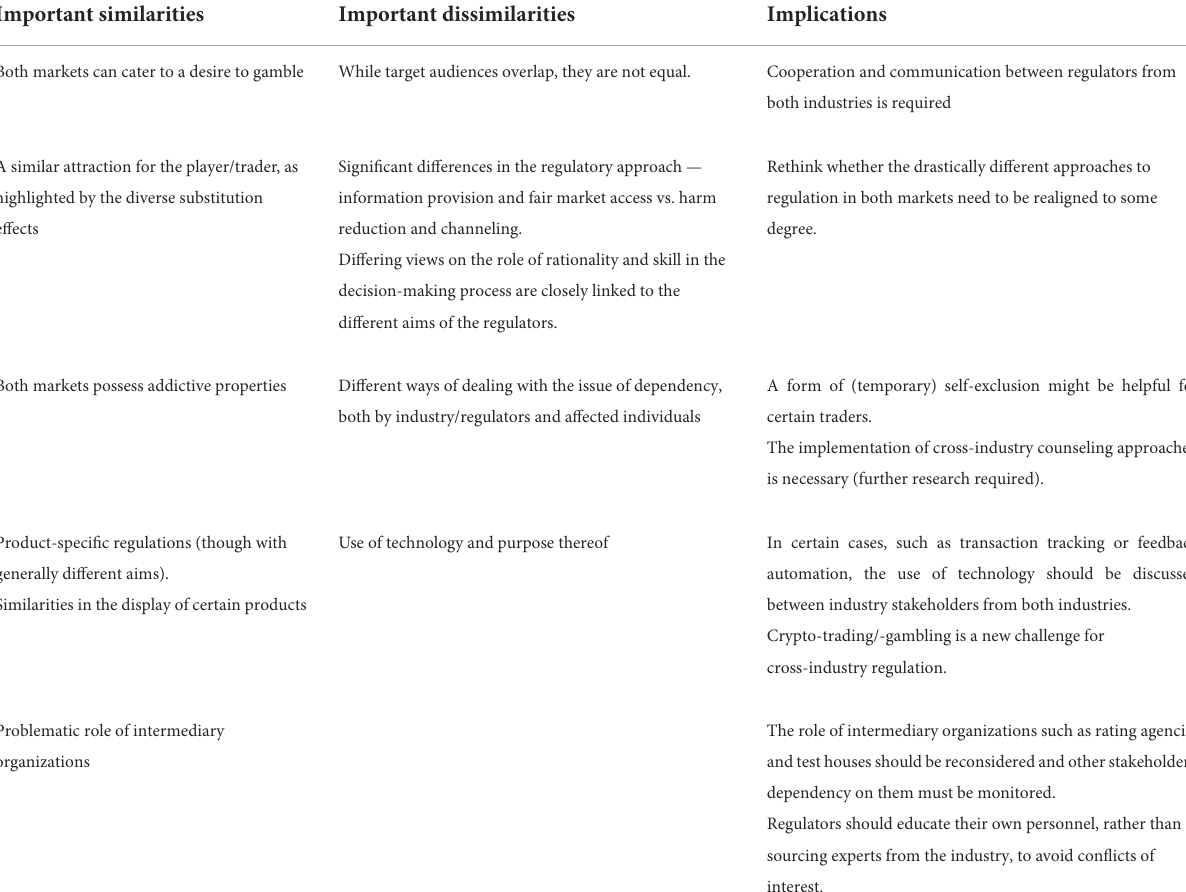
TABLE 1 Summary of the main